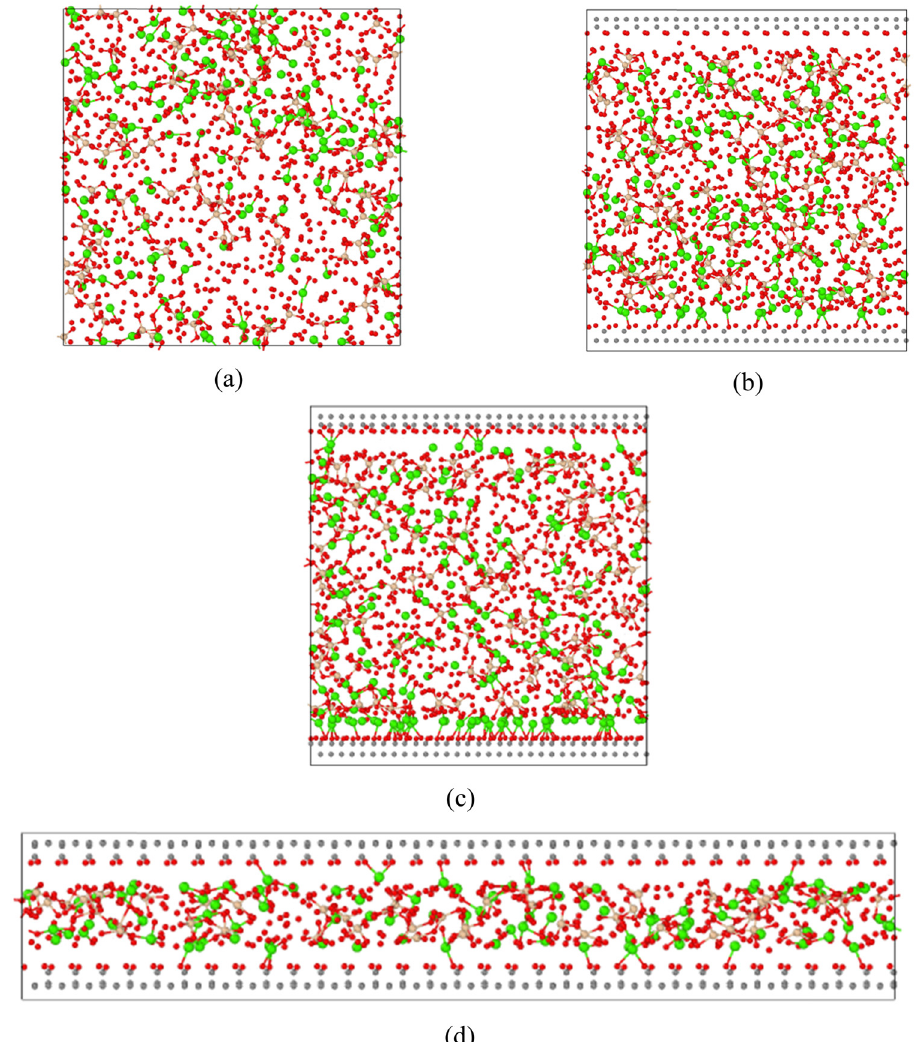
Figure 2: Atomic con fi gurations of C – S – H. ( a ) Control, ( b ) GCOOH40 - 25, ( c ) GCOOH40 - 50, and ( d ) GCOOH10 -